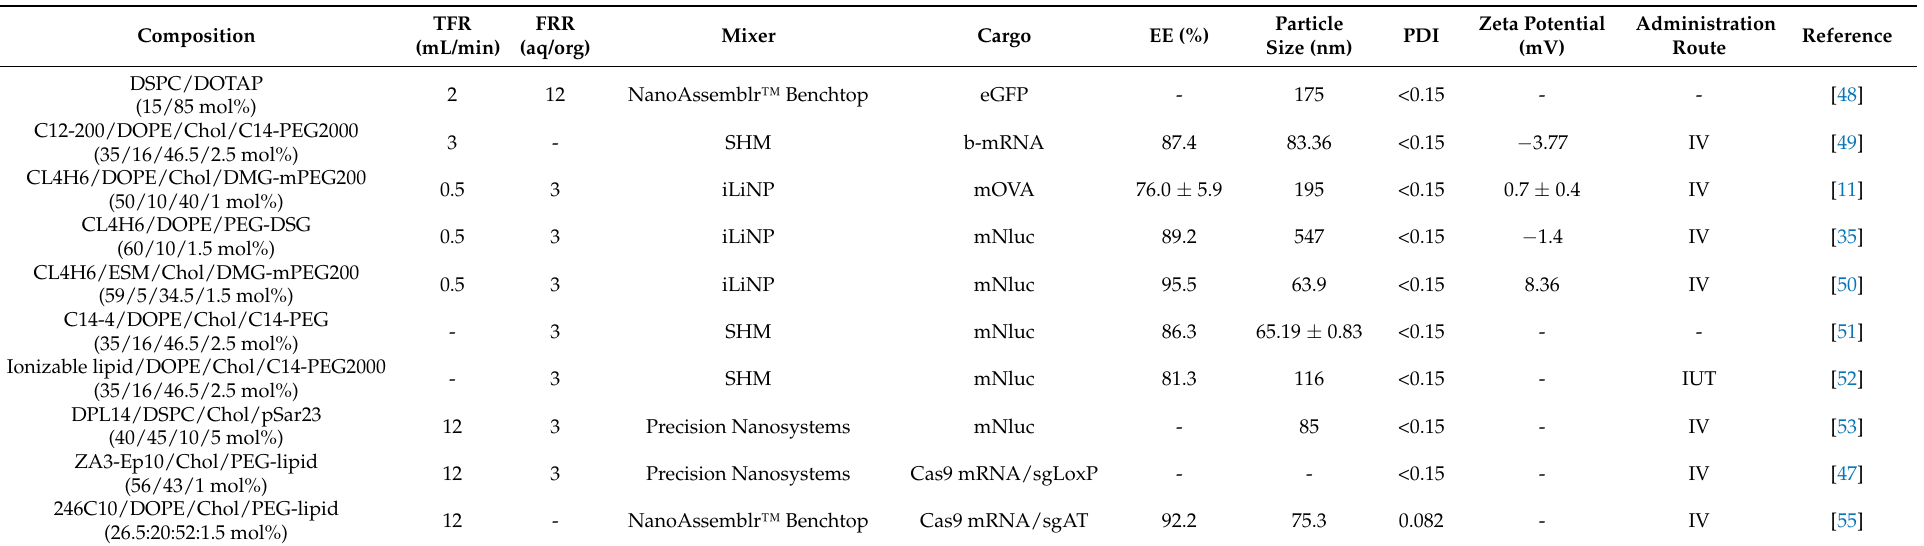
Table 3. mRNA LNPs for drug delivery and their physicochemical